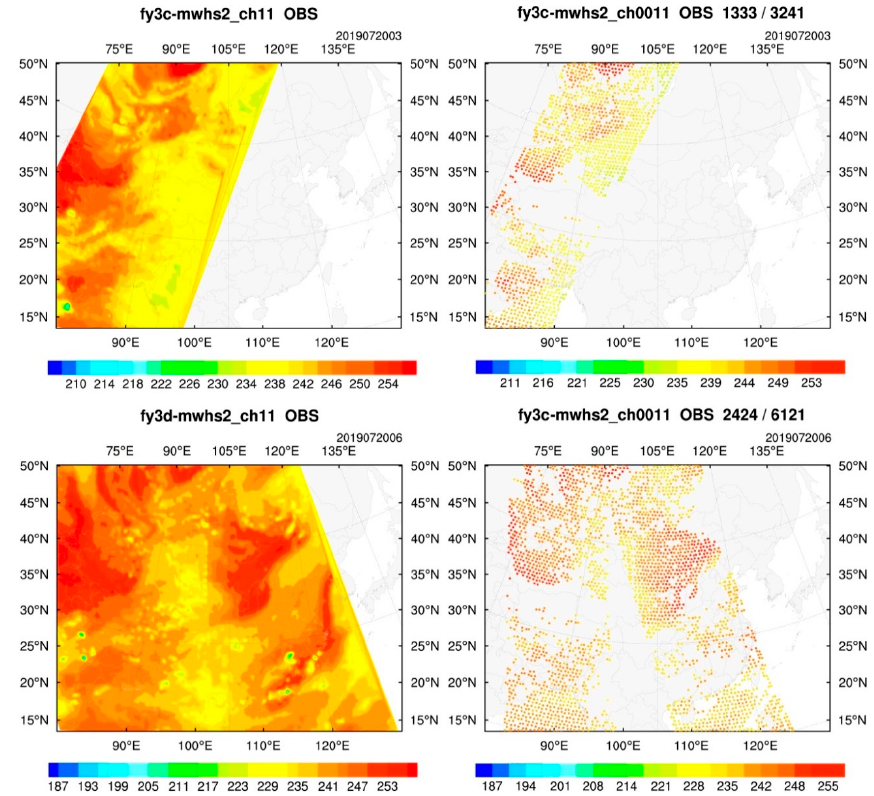
Figure 2. The spatial distribution of MWSH-2 channel 11 brightness temperatures before and after all quality control procedures at 0300 UTC 20 July 2019 for satellite FY-3C and at 0600 UTC 20 July 2019 for FY-3D, respectively.